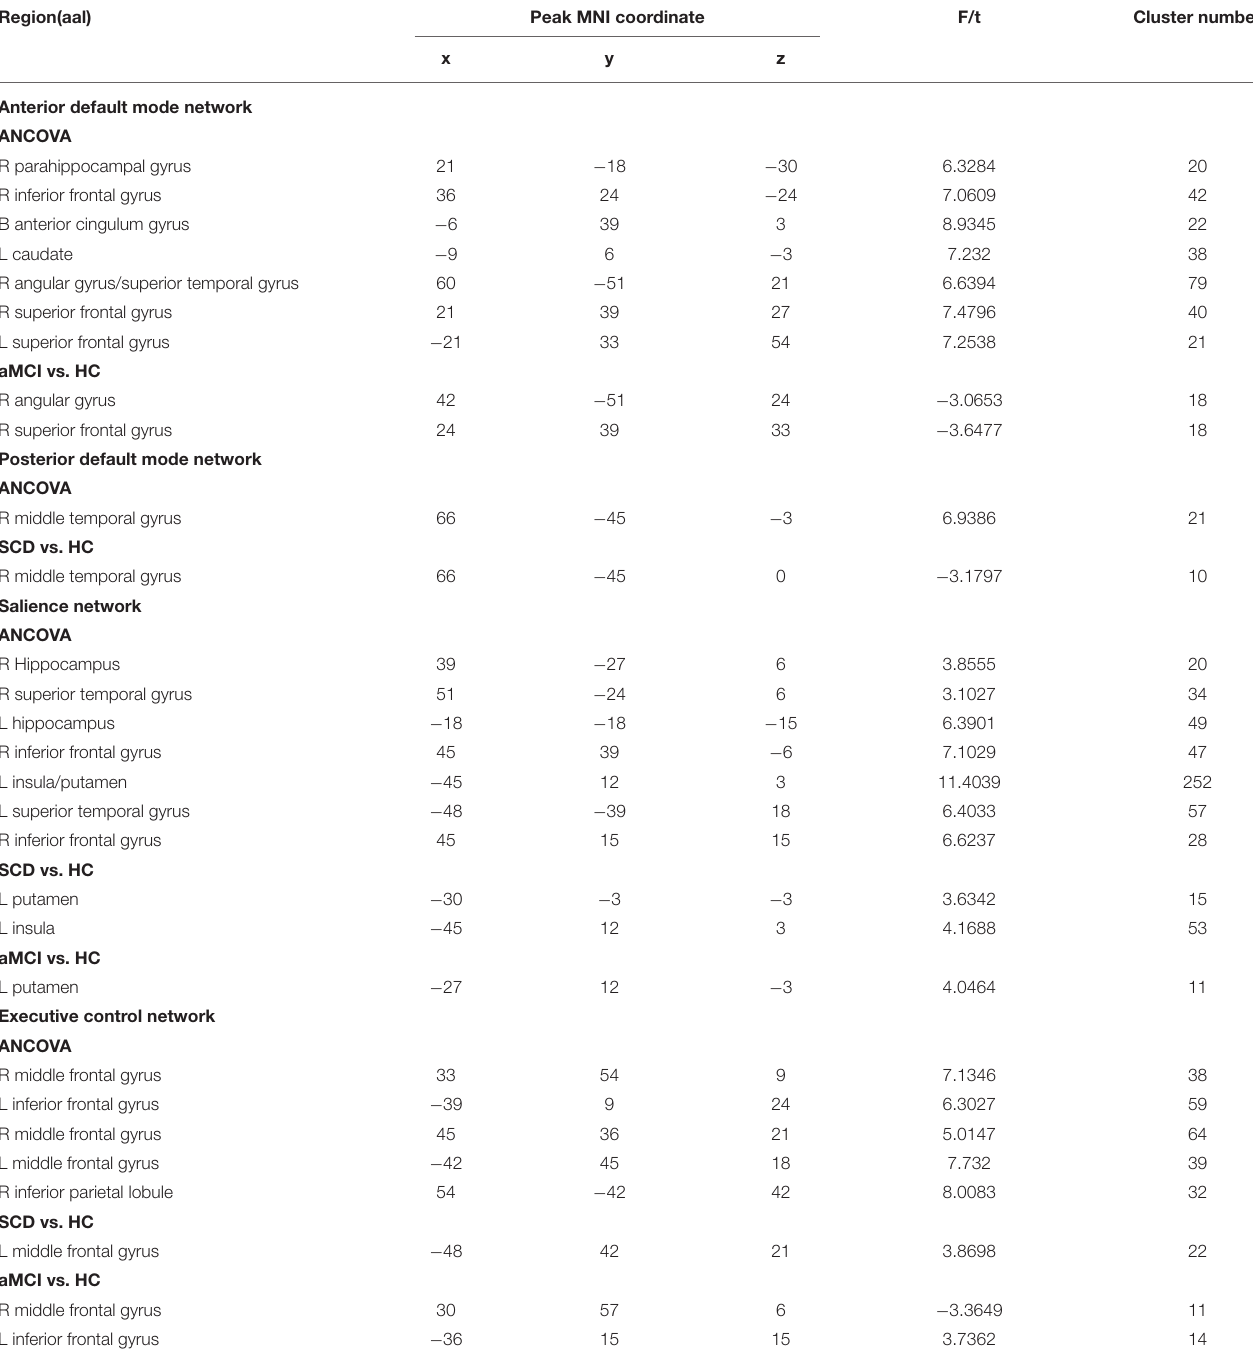
TABLE 2 | The difference of dynamic functional connectivity variability in default mode network across three groups. Region(aal) Peak MNI coordinate F/t Cluster